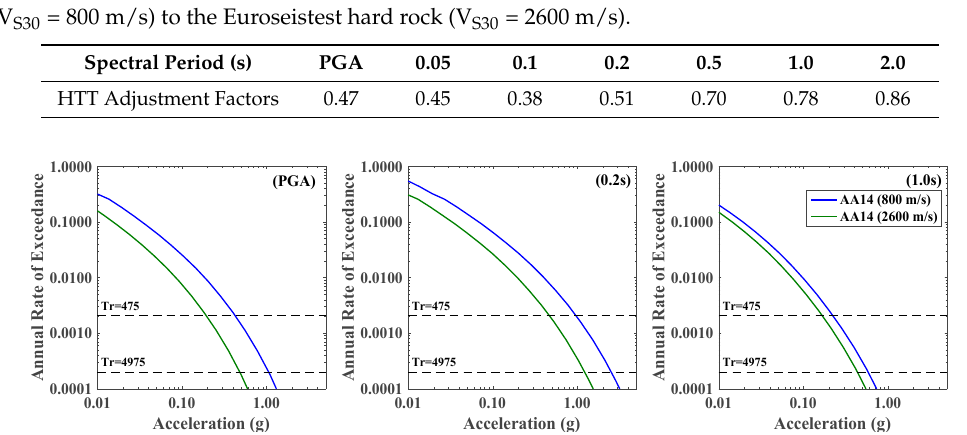
Table 2. Host-to-target adjustments factors derived using LA17 hazard curves from a standard rock